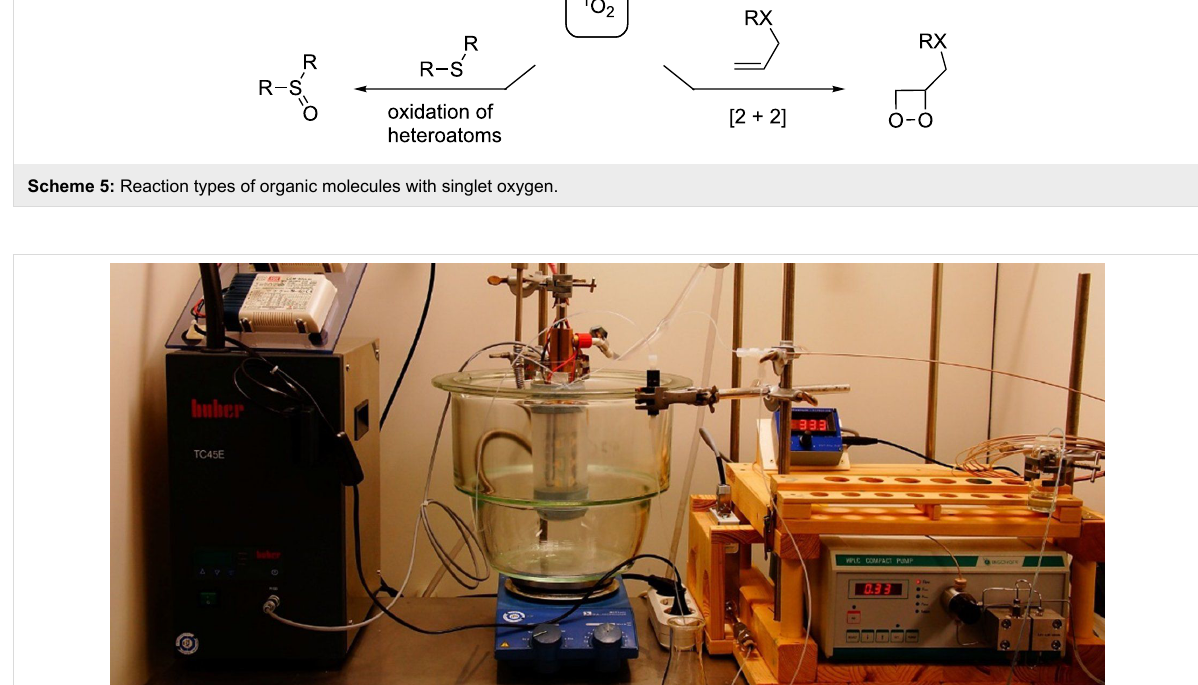
Figure 7: Home-made flow reactor and peripheral devices for photochemical reactions at light/liquid/gas interfaces.